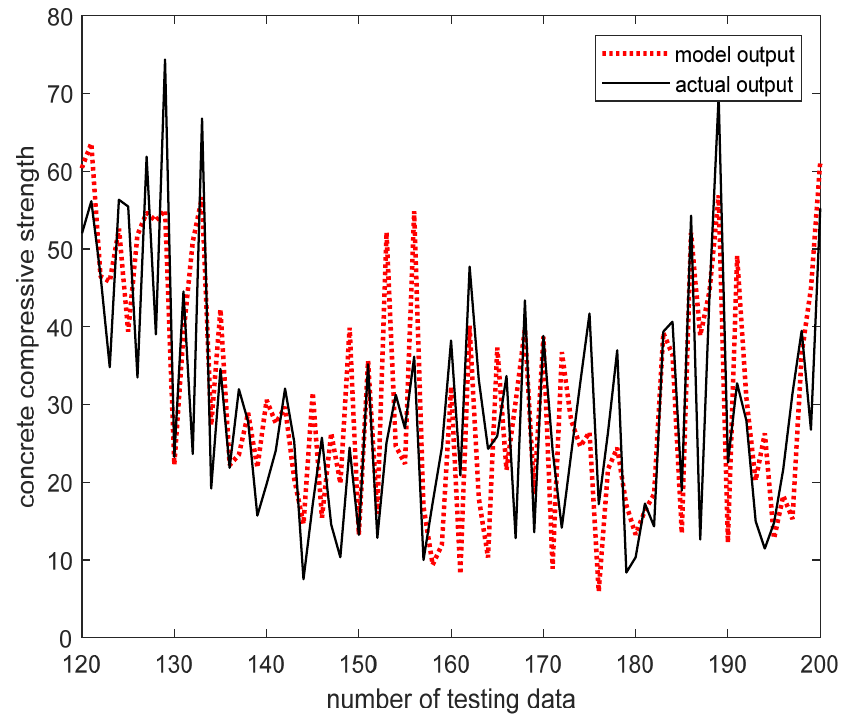
Figure 15. Comparison of the output of the optimized CGK-based fuzzy granular model of the aggregated structure and the real output.